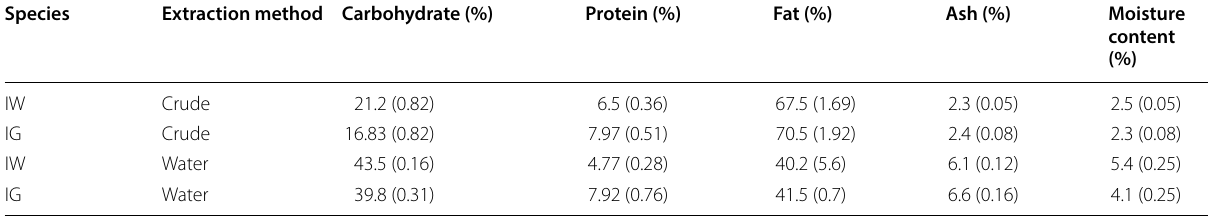
Table 3 Chemical composition of IW and IG kernels content before and after defatting in water Species